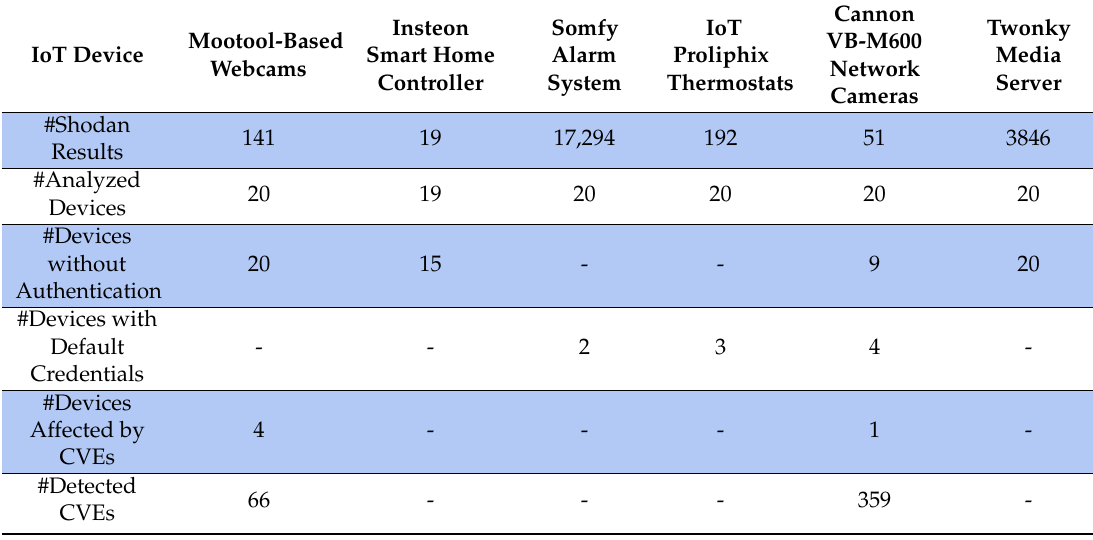
Table 1. Summary of the most relevant results obtained by the students of class